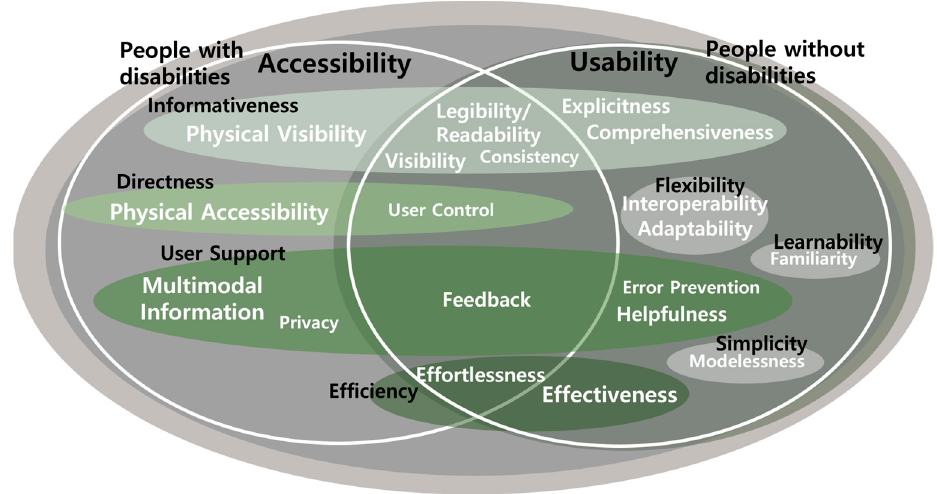
Figure 6. Mapping of categories of accessibility and usability for kiosks.